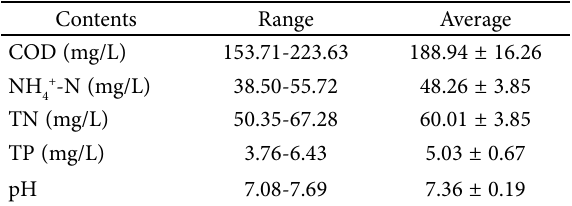
Table 2. Characteristics of real domestic sewage used in this